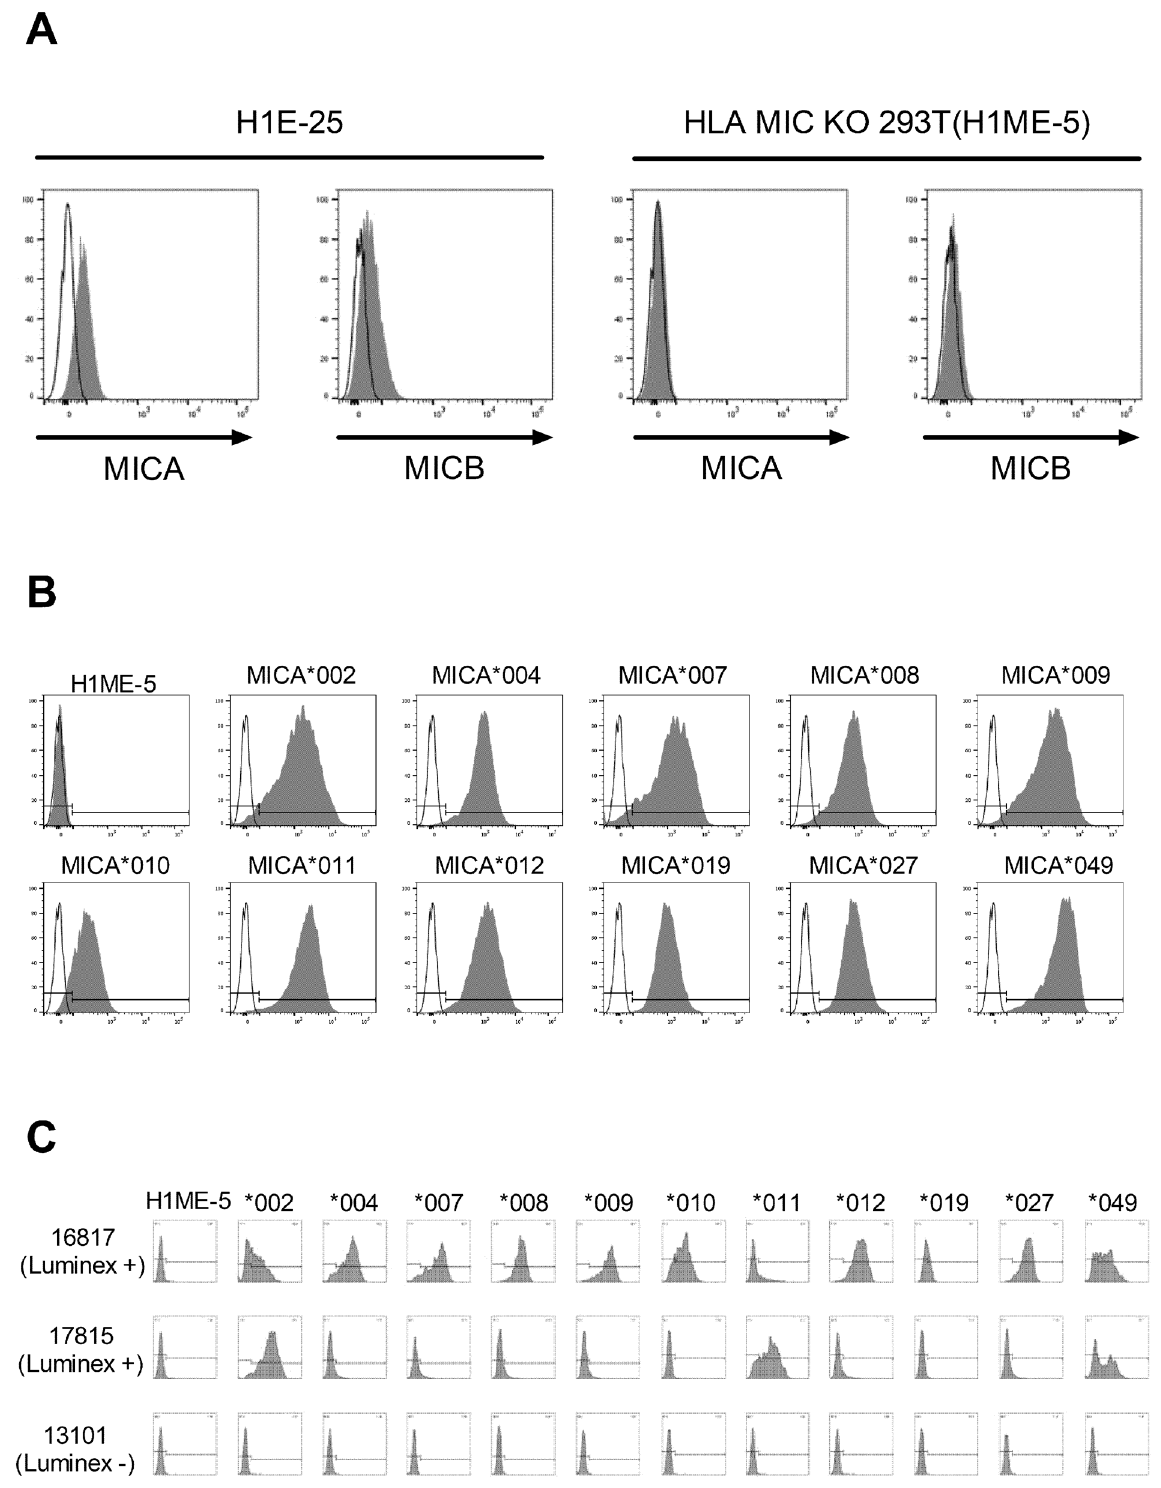
Figure 2. Establishment of cell lines expressing a single MICA allele using HEK-293T cell line (H1ME-5) from which both MICA and MICB genes have been deleted in addition to the HLA class I genes (H1E-25). ( A ) The expression of surface MICA and MICB molecules in H1E-25 and H1ME-5 HEK-293T cell lines. ( B ) Establishment of cell lines expressing single MICA allele from H1ME-5 HEK-293T cell line. Transduction and cloning using lentivirus vectors expressing each MICA allele genes, including MICA*002, *004, *007, *008, *009, *010, *011, *012, *019, *027, and *049. The MICA molecules expressed on the surface of selected cells were confirmed by anti-MICA PE (gray) antibody. ( C ) Representative response patterns of single MICA allele-expressing cell lines to the sera of two positive (16,817 and 17,815 MFI) and one negative (13,101 MFI) serum confirmed by the Luminex